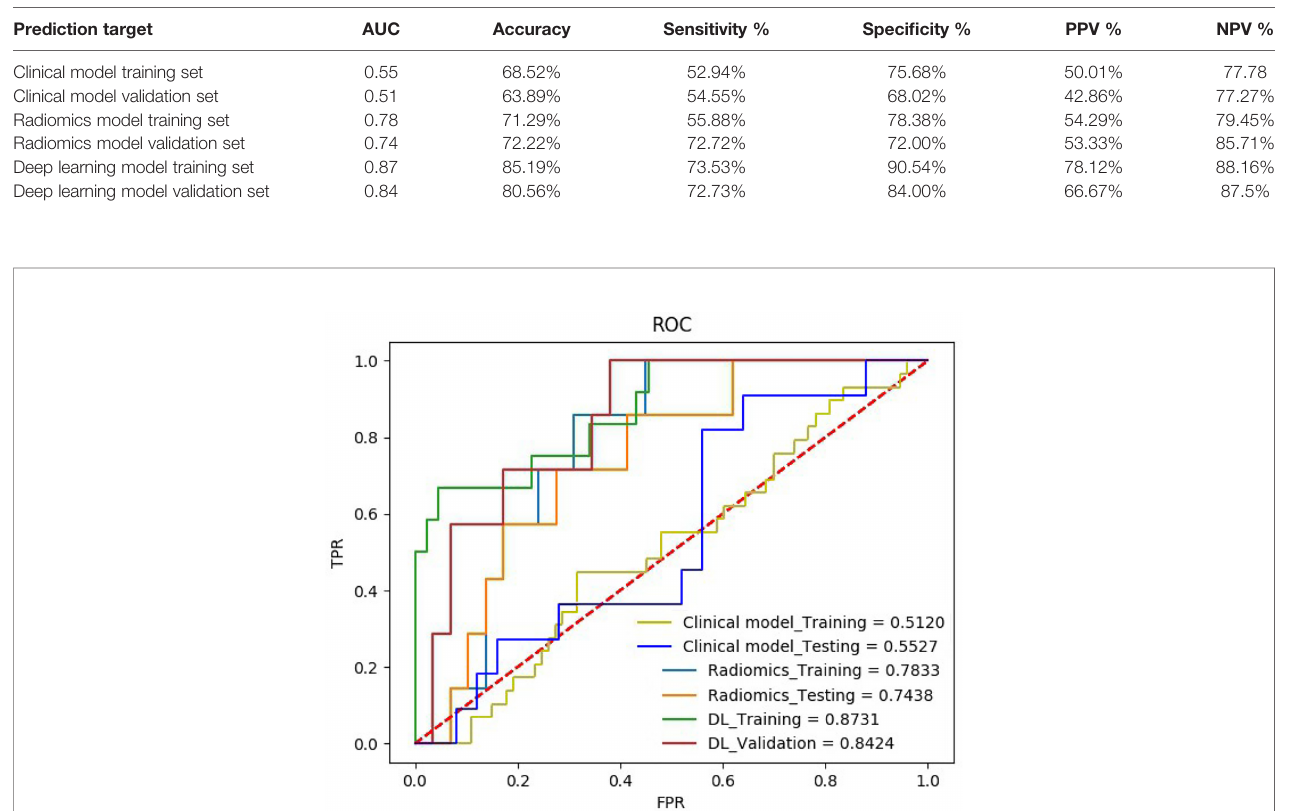
FIGURE 5 | The receiver operating characteristic curve (ROC) of the HER2 on the training set and the testing set.